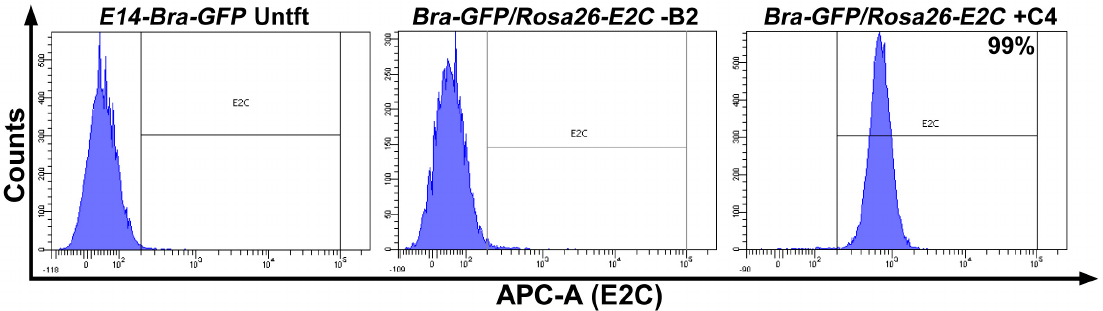
Figure 3. Flow cytometry analysis of E2C expression of the selected 3 ′ -HA PCR-screened positive clone named +C4. Untransfected (Untft) E14-Bra-GFP mESCs and a negative clone named − B2 was used as the negative controls. 10,000 events were counted for each sample.